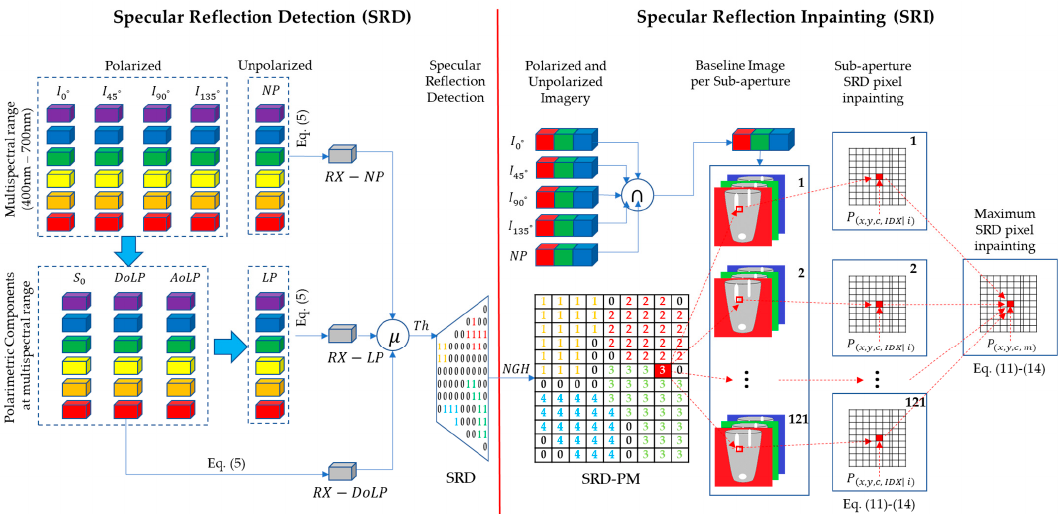
Figure 6. Proposed two-fold framework for specular reflection detection (SRD) and specular reflection inpainting (SRI).